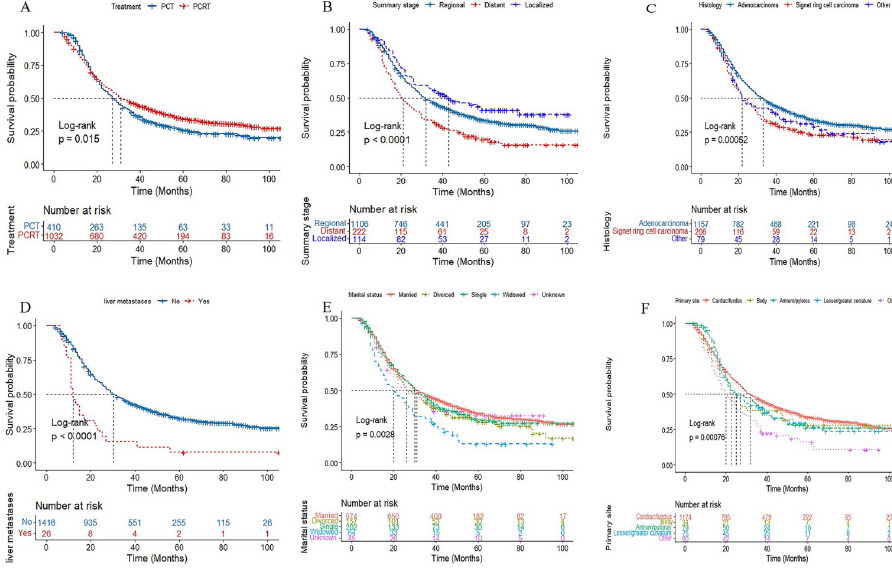
Fig 1. Kaplan-Meier survival curves of clinically related factors in advanced stage gastric patients. (A-F) The dotted lines indicate the median survival time of patients. Overall survival for patients with (A) treatment, (B) summary stage, (C) histology, (D) live metastases, (E) marital status, and (F) primary